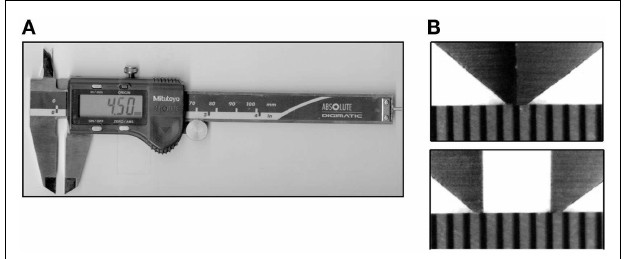
FIGURE 1 | Calipers . (A) The calipers used in the study, opened to a tip separation of 4.5mm. (B) Magnified images of the caliper tips above a scale with marks at 0.5mm intervals.Top: closed caliper tips (0mm separation); bottom: tips opened to 2.0mm